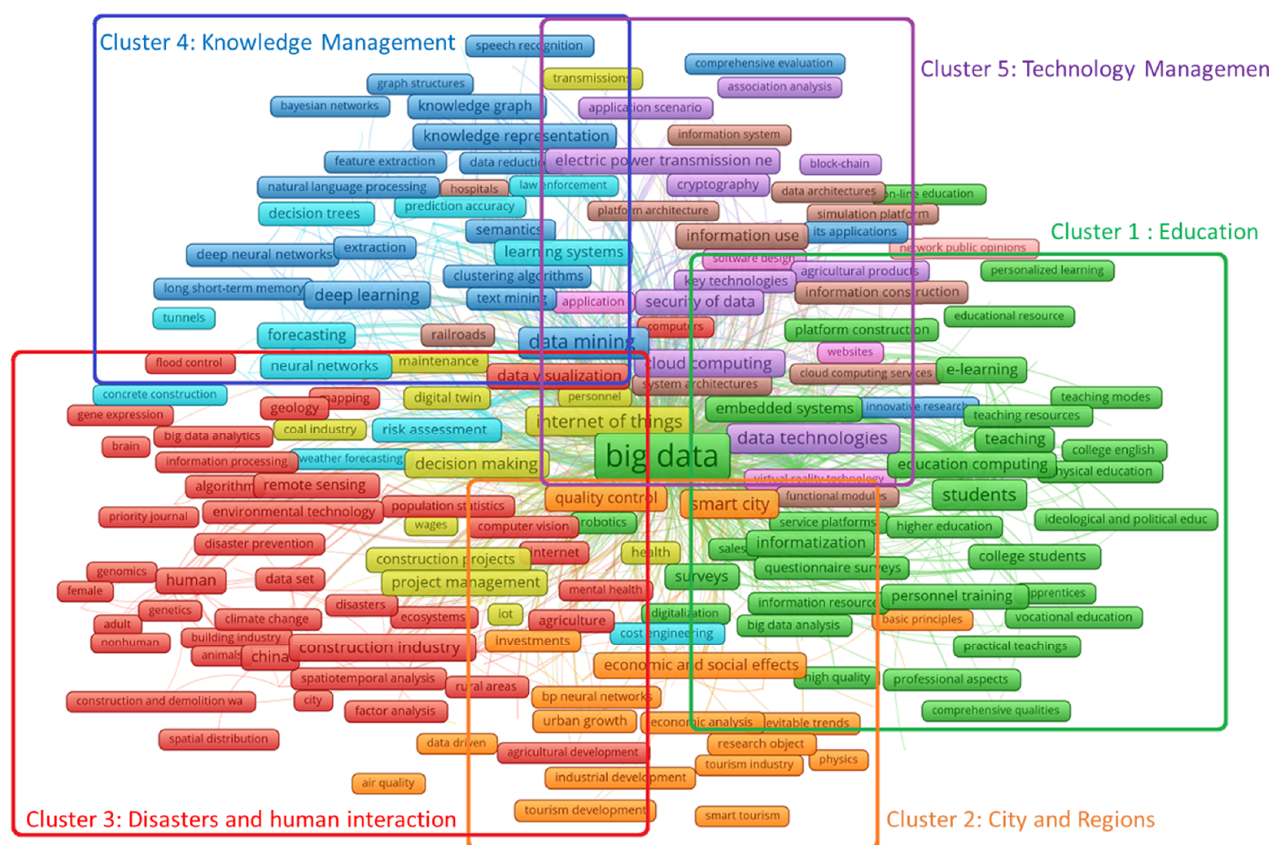
Figure 4. Five key clusters of big data in construction based on keywords reported in the reviewed literature.